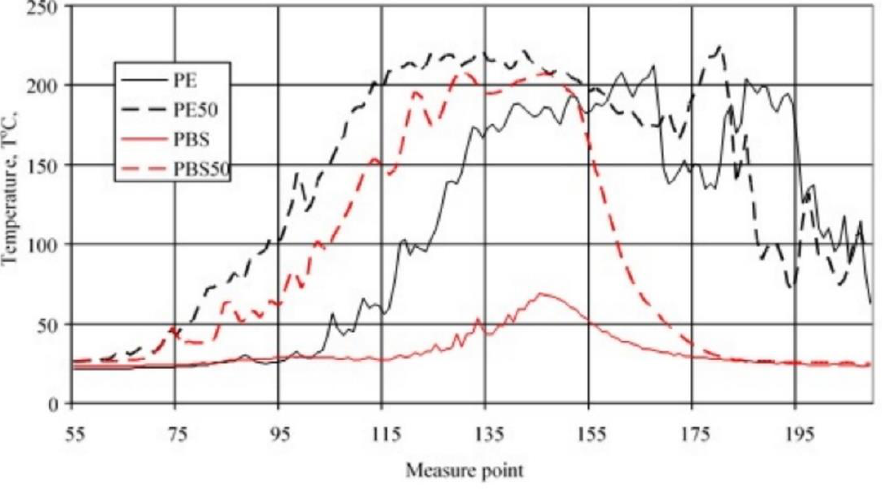
Figure 12. Temperature along the vertical axis of burning samples of unmodified PE and PBS (PE, PBS) and those containing 50% filler content (PE50, PBS50).